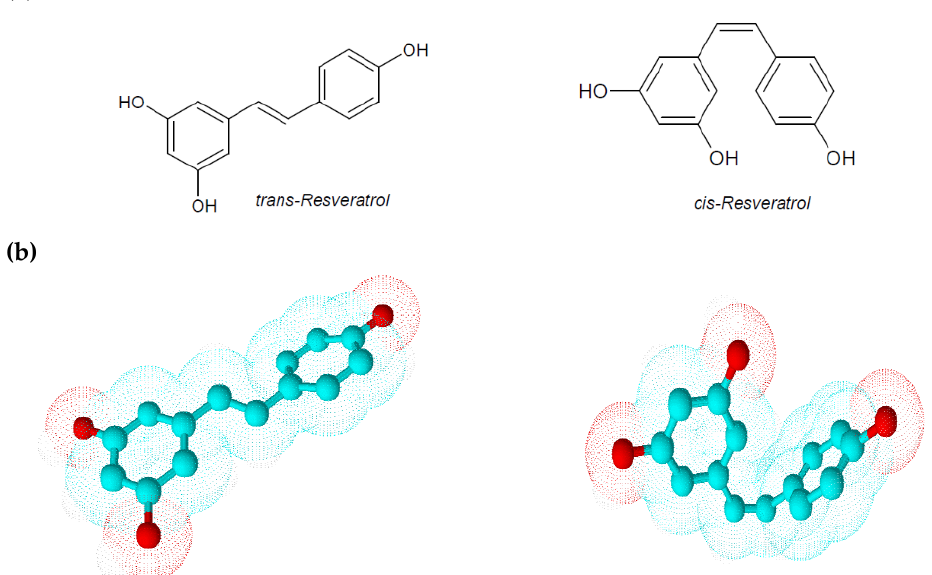
Figure 1. ( a ) Chemical structures of trans -resveratrol and cis -resveratrol; ( b ) 3D chemical structures of trans -resveratrol and cis -resveratrol.